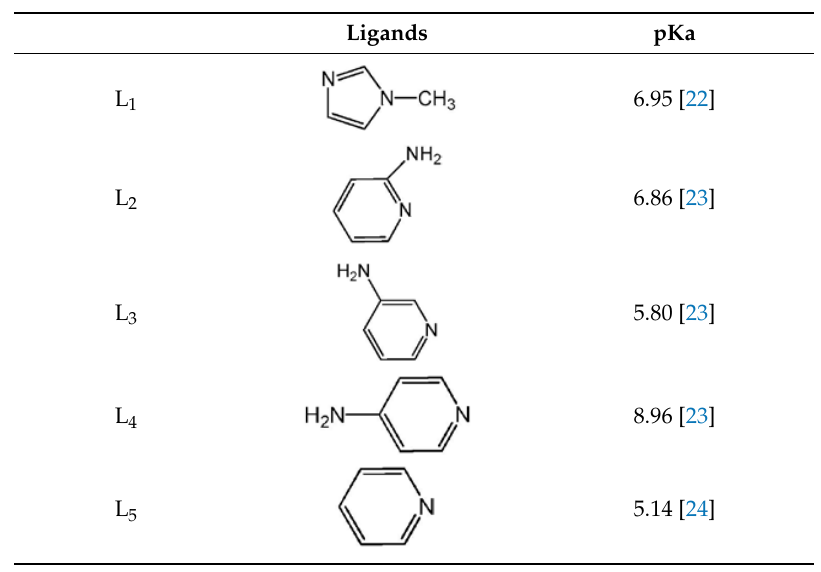
Table 3. pKa values of amine